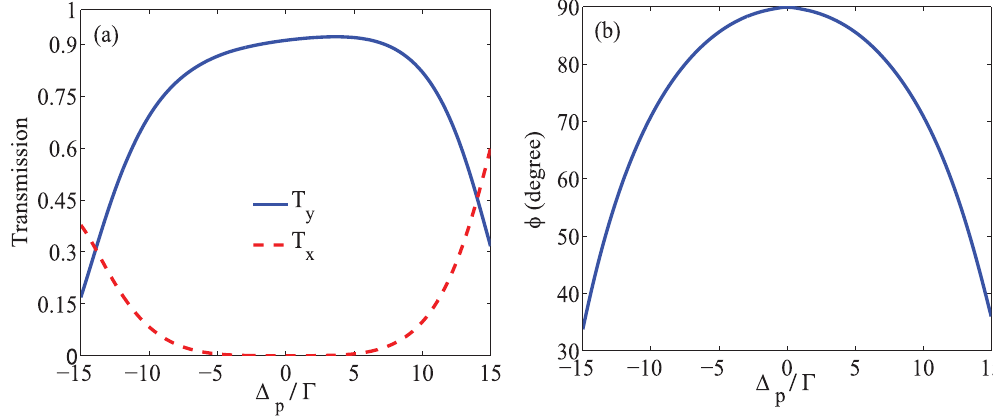
Figure 3. Intensity of the transmission ( a ) in direction ^ x (dashed) and ^ y (solid) and the MOR angle ( b ) versus detuning of the probe field. The taken parameters are the same used in Fig. 2.